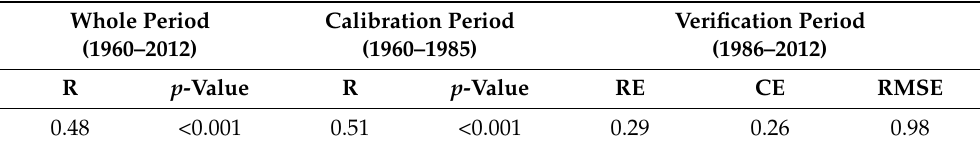
Table 2. The calibration-verification statistics of mean June–July temperature reconstruction.